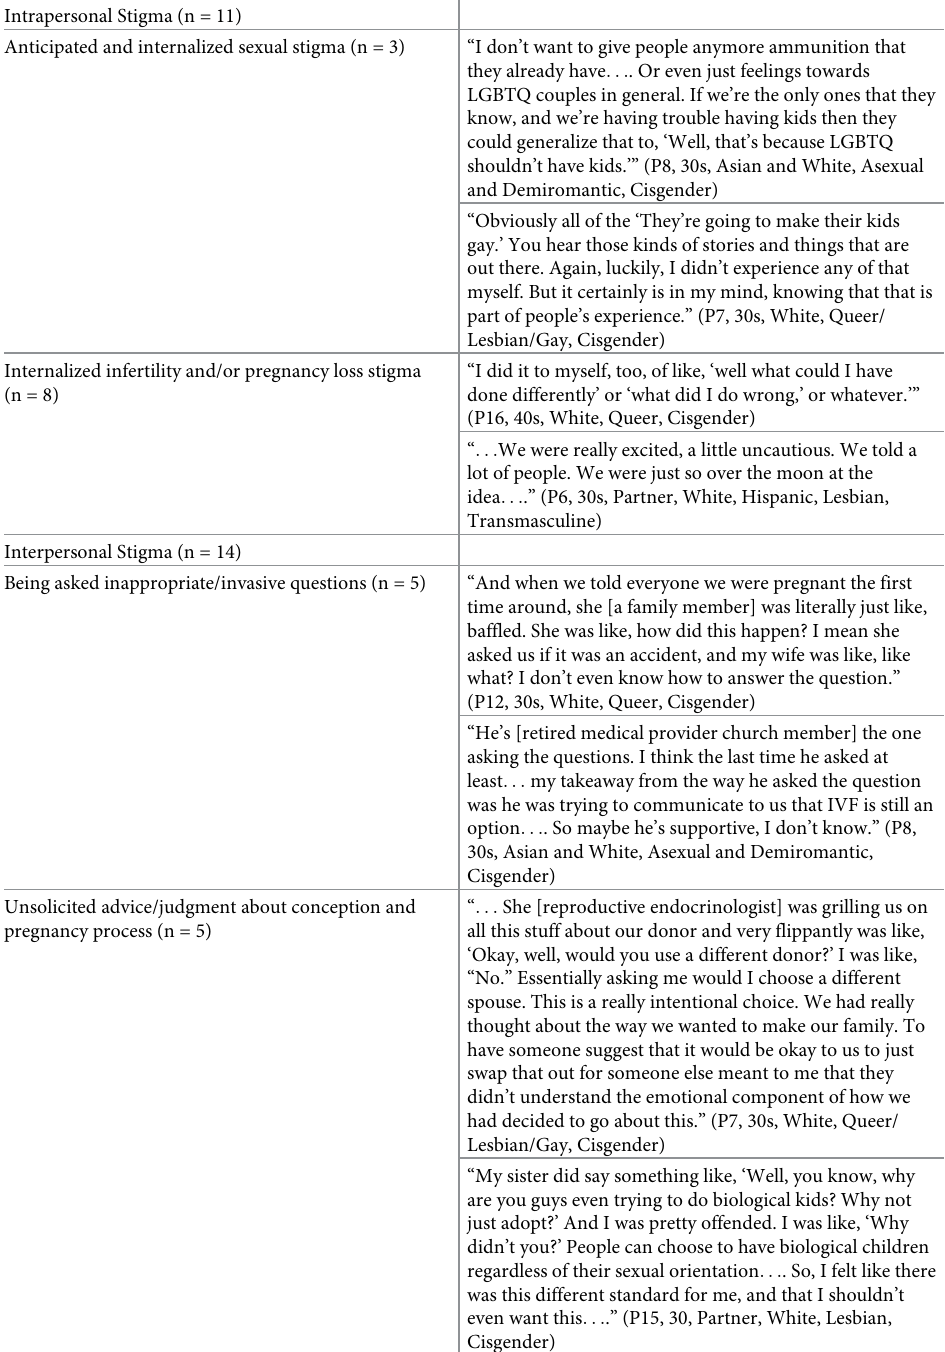
Table 3. Multi-level stigma in LGBTQ+ people’s experiences of conception, pregnancy, and loss: Sub-themes, def- initions, and